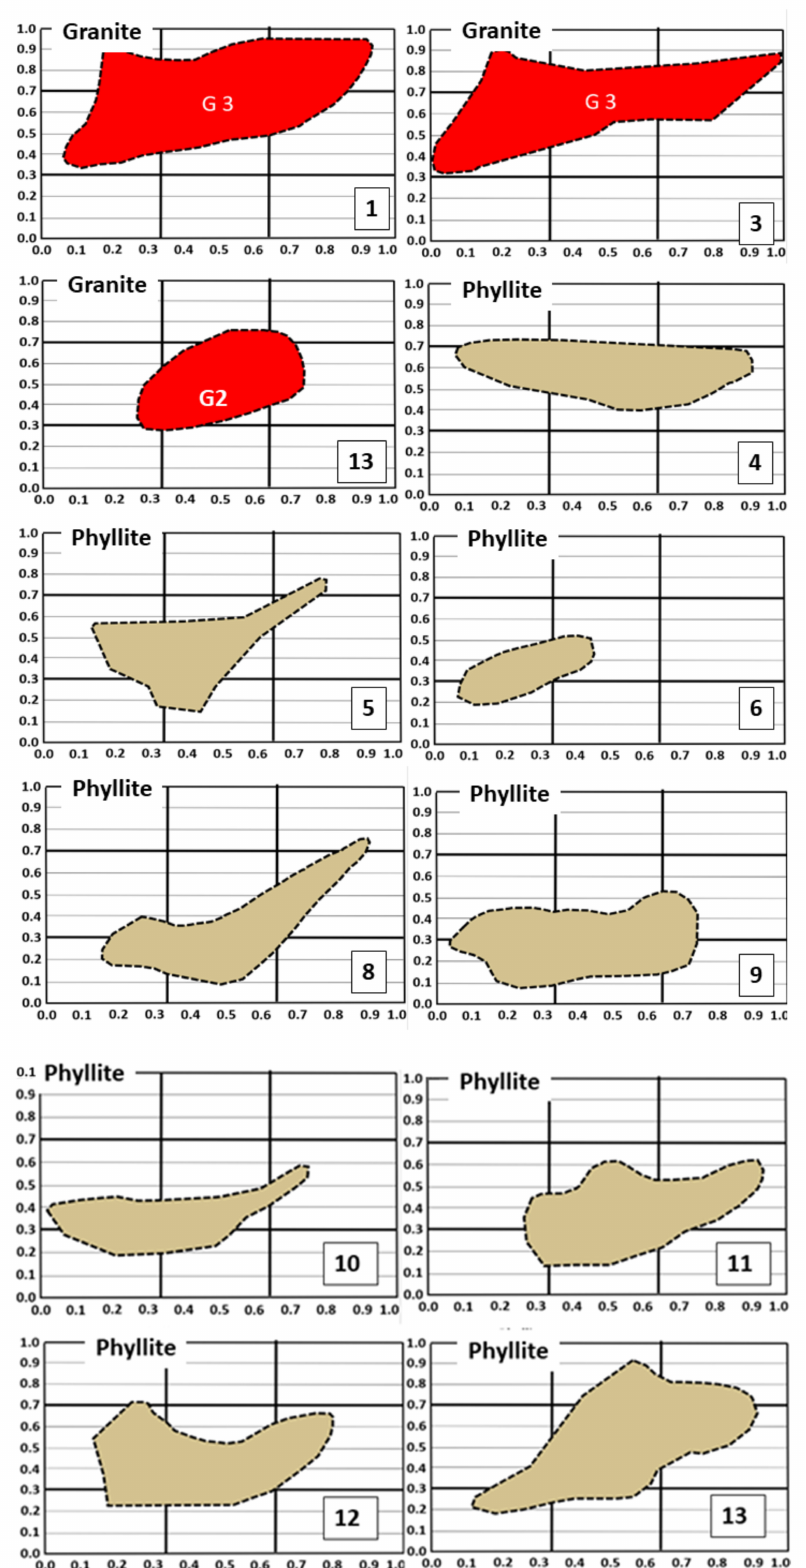
Figure 7. Grain morphology of granitic and phyllitic lithoclasts as a function of the distance to source given by the site numbers. See also geological base map of Figure 3 for